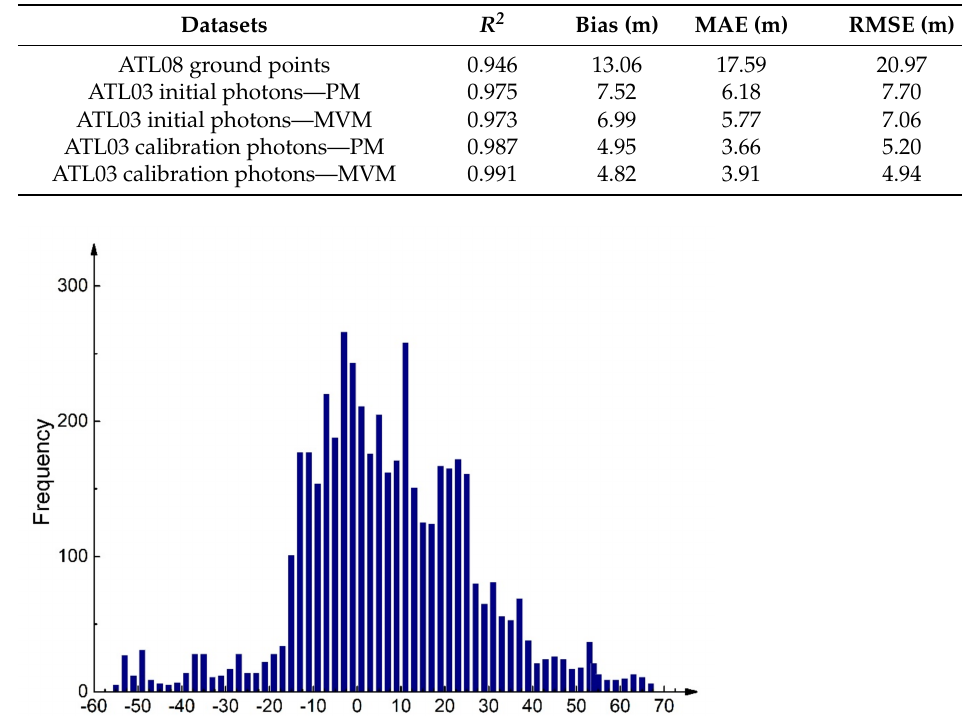
Table 1. Statistical errors of ground elevation based on ICESat-2 data, using different methods.